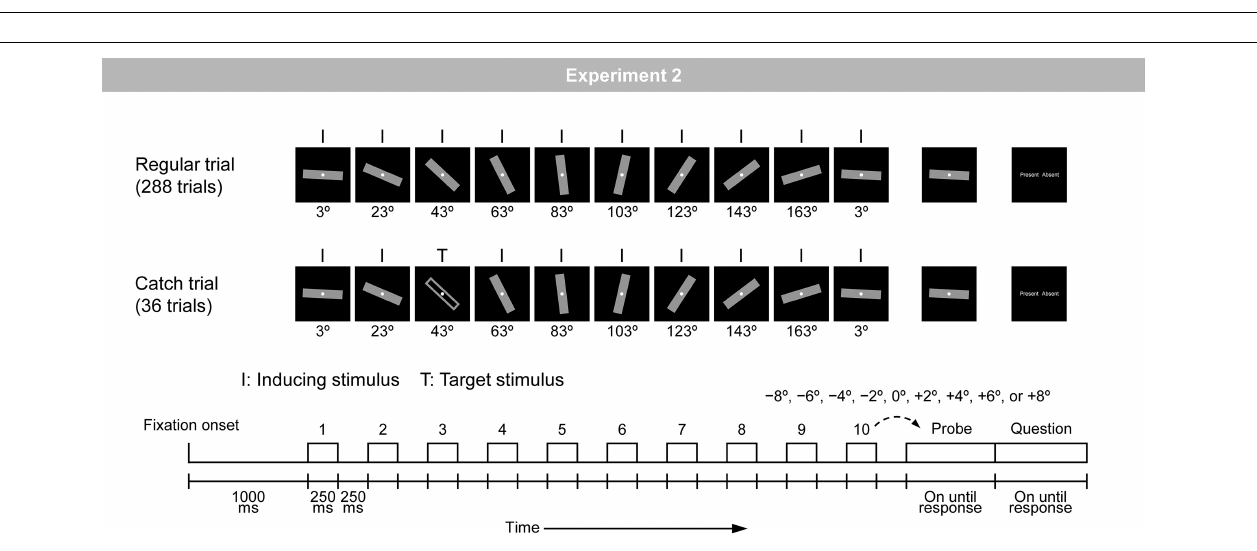
FIGURE 1 | Schematic illustration of the regular and catch trials in Experiment 1. A bar was rotated regularly with a step of 18 ◦ .